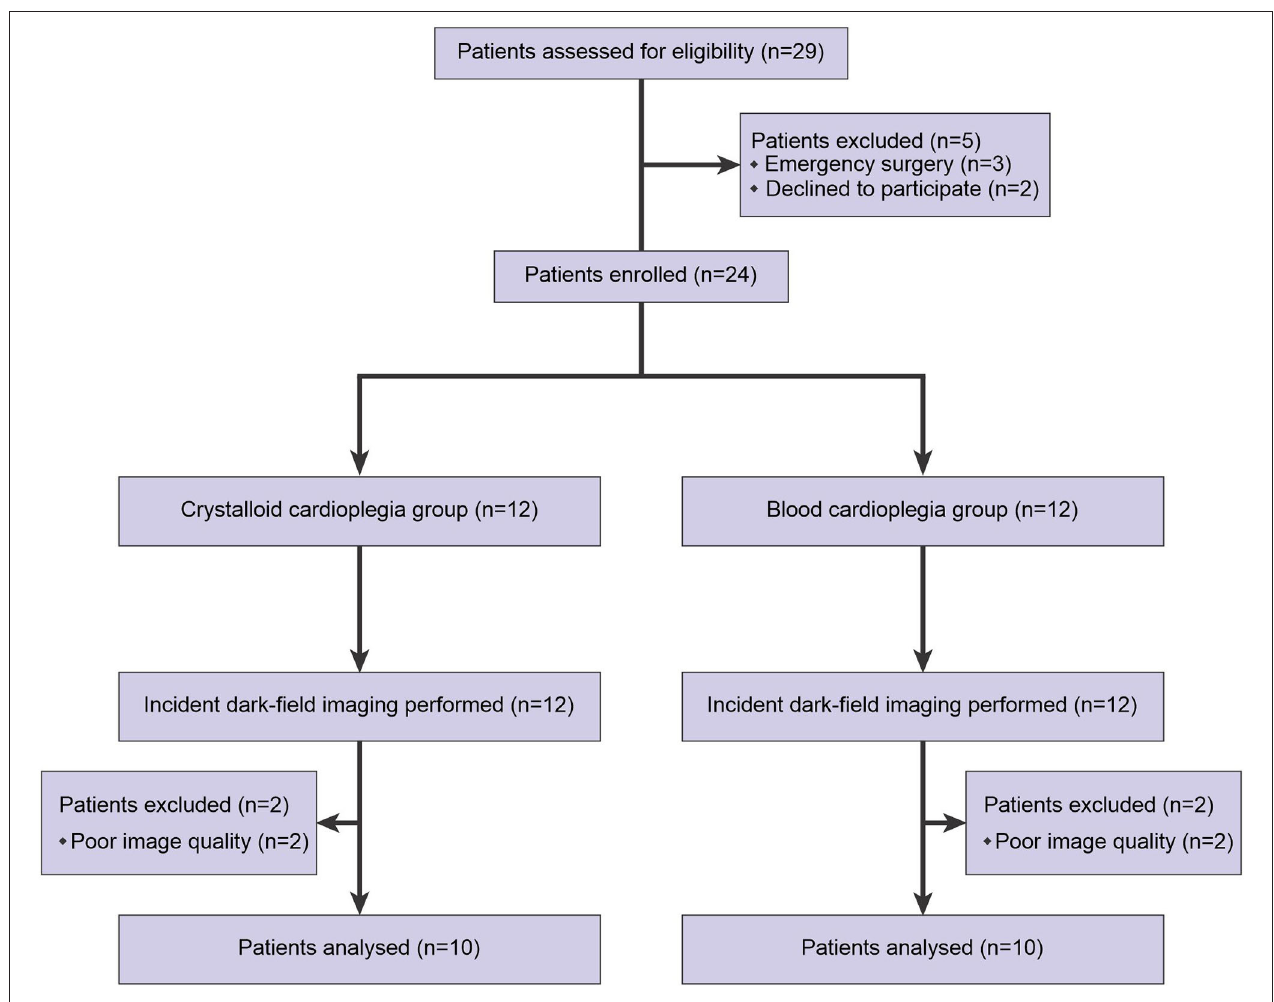
FIGURE 1 | Diagram of recruitment flow to the